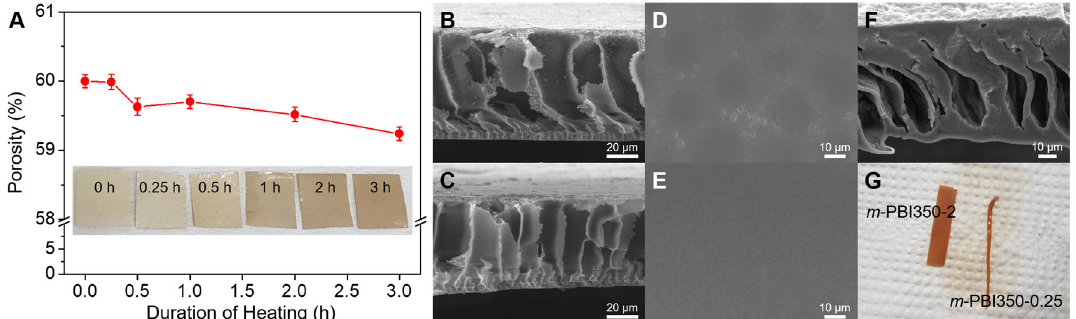
Figure 3. ( A ) n -Butanol adsorption porosity (%) values of m -PBI350-x membranes with respect to duration of heating time at 350 °C (inset: digital camera photographs of m -PBI350-x membranes). Scanning electron microscopy images of the cross-section of ( B ) m -PBI350-0 and ( C ) m -PBI350-3; and the membrane surface of ( D ) m -PBI350-3 glass side and ( E ) air side. ( F ) Cross-section of m -PBI350- 0.25 and ( G ) image of the membrane after acid removal.